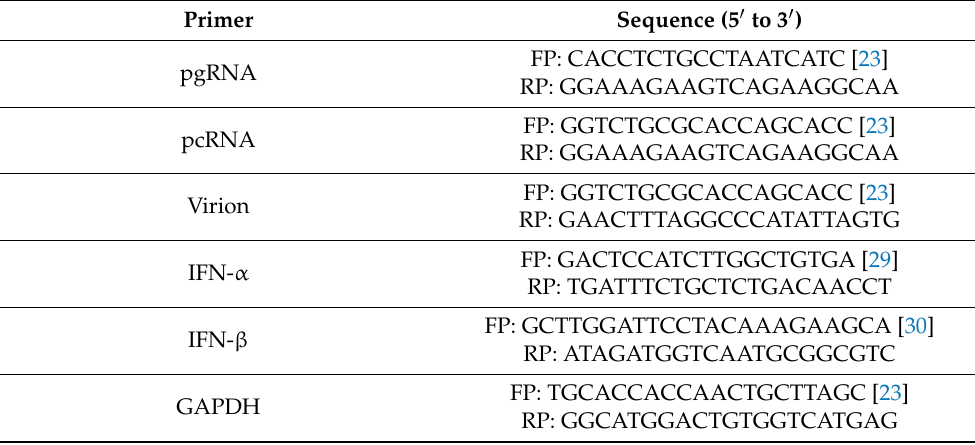
Table 1. The following primers are used for the qPCR studies